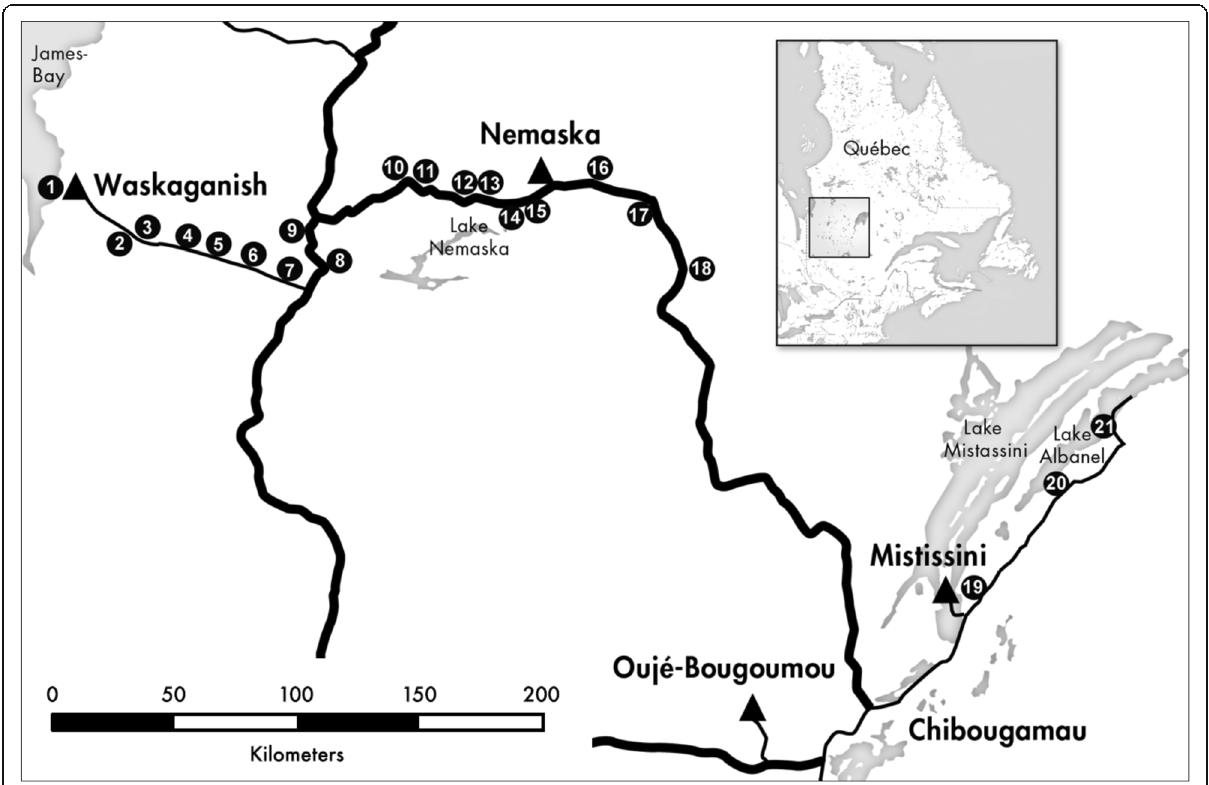
Fig. 1 Map representing plant sampling locations (white number in black circle). The markers represent both the high and low land locations since they were next to each other. For example the circle labelled “ 3 ” represents bog and forest populations. At this location materials for B3N, B3B, B3C, F3N, F3B and F3C were collected. Cree communities are represented by a ▲ symbol. This map was simplified using photoshop, from “ The Far North Nunavik and James Bay ” tourist map which was sourced from the Base de données géographiques et administratives du Québec